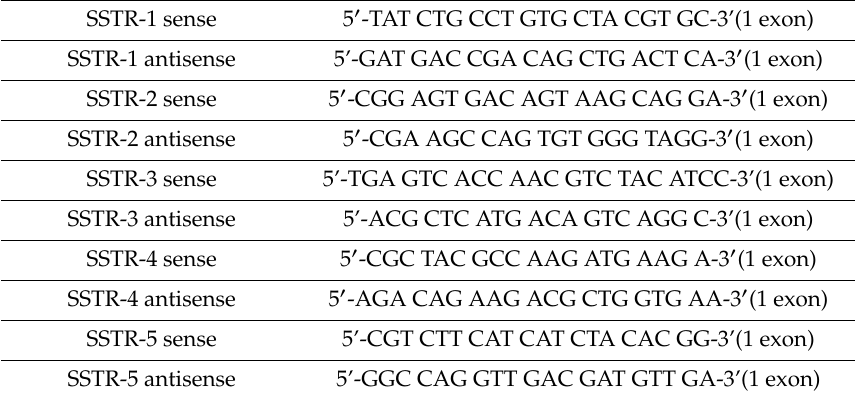
Table 4. Sequences of SSTR-1, -2, -3, -4, -5 primers used for RT-PCR